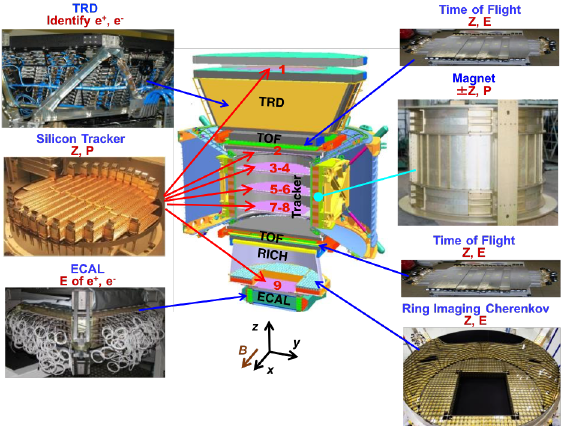
Figure 1. A scheme of the AMS-02 detector, showing the spec- trometer and the main sub-detectors [6].